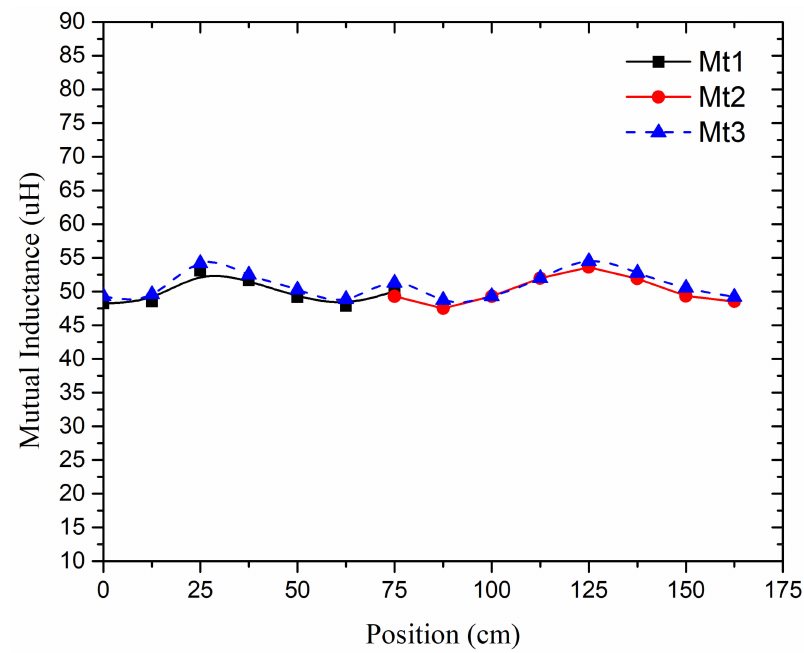
Figure 10. The measured mutual inductance under different